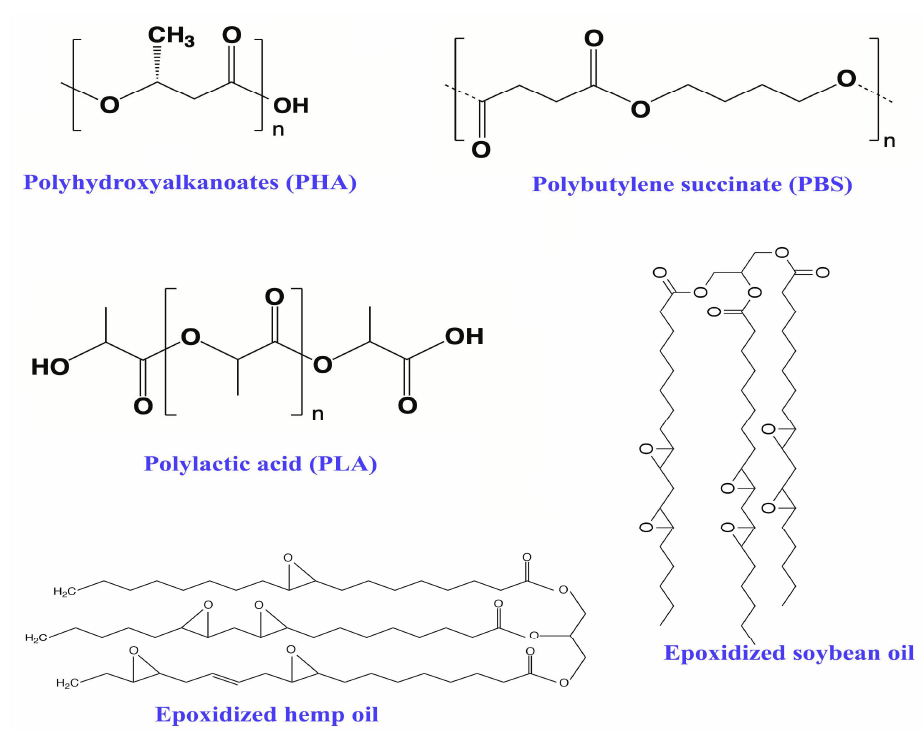
Figure 3. Chemical structure of commonly used biopolymers.